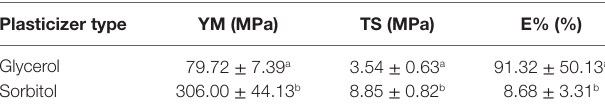
TaBle 4 | Young’s modulus (YM), tensile strength (TS), and elongation at break (E%) depending on different types of plasticizers (66.7% w/w protein).